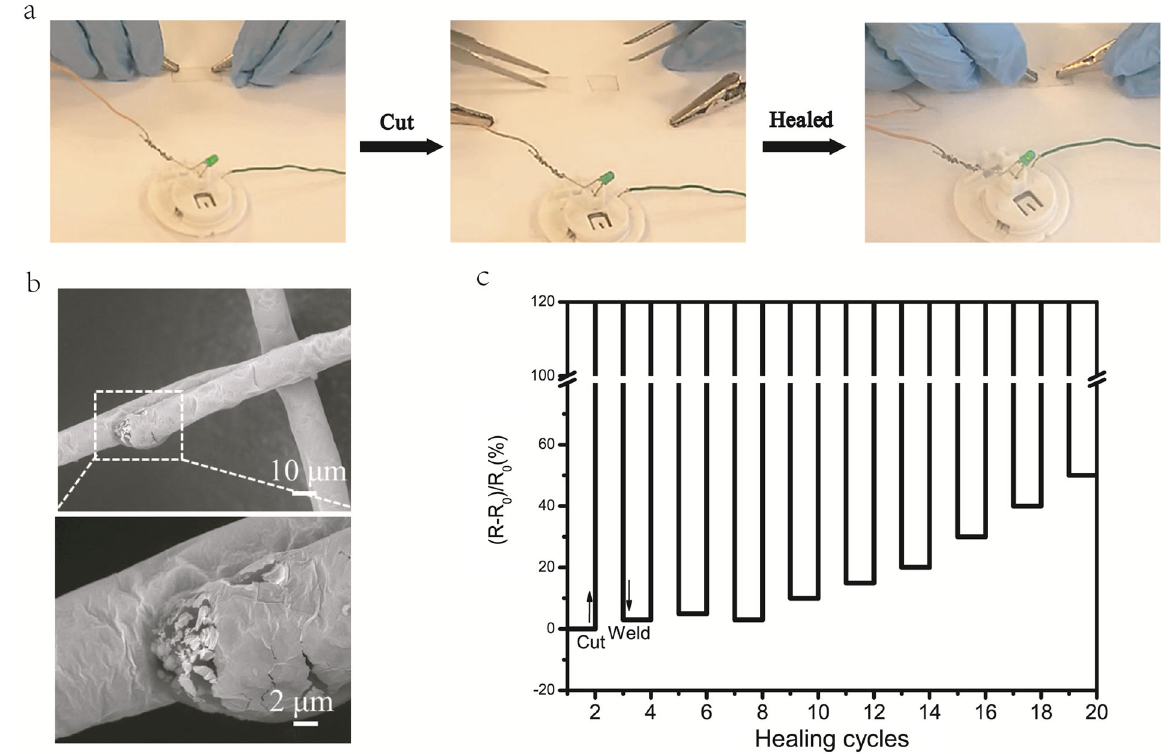
Fig. 5 a Images of Au network-based transparent electrode connected with a LED light in a circuit. From left to right is the original, after damaged, and after healing state of this network. The entire welding process is shown in Supporting video 2. b Morphology of an Au network after welding. c Resistance changes of the Au network during 10 cut and healing